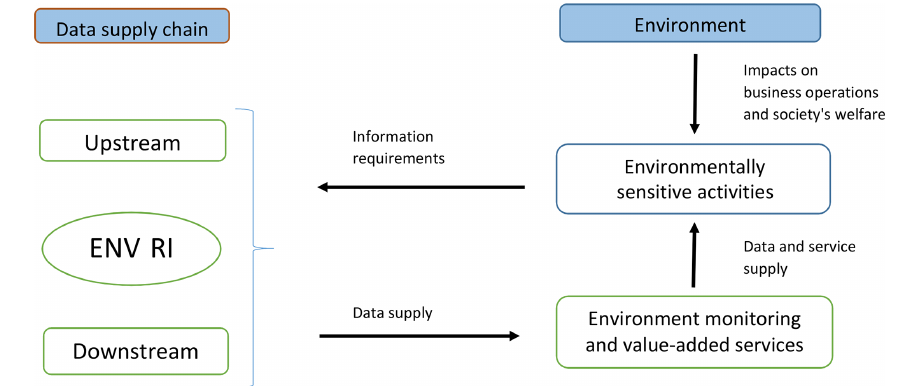
Figure 3. Feedback impacts: environmentally sensitive activities require environmental information and are supplied with data, monitoring services and forecasts by e.g. Copernicus and other value-added services.